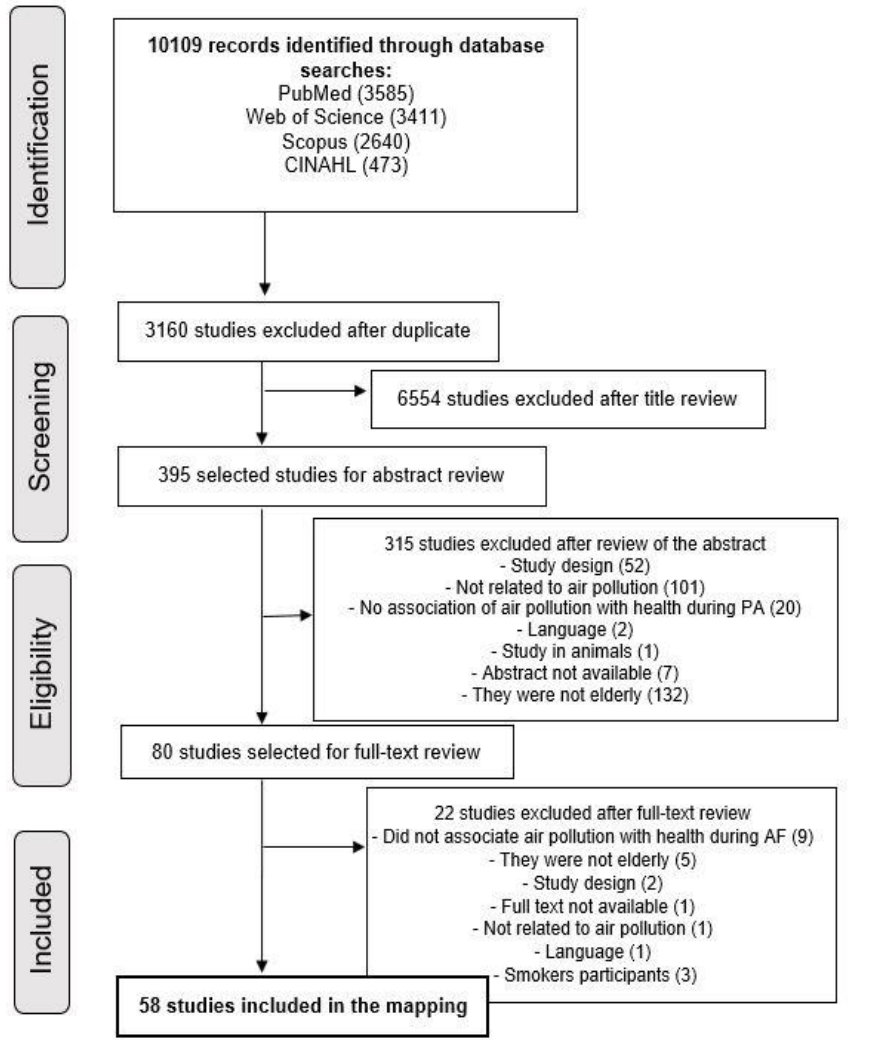
Figure 1. PRISMA flowchart illustrating the literature search and selection process.